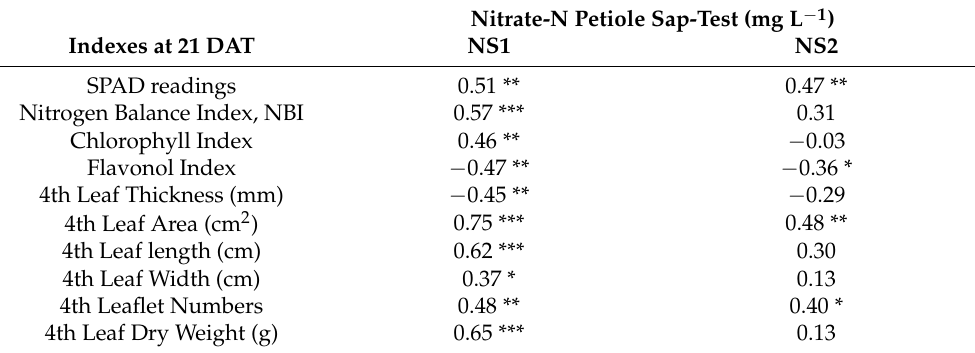
Table 3. Pearson’s correlation coefficients between Nitrate-N Petiole Sap-Test and indexes measured on the 4th leaf of potato plants grown in aeroponics with Otaz ú ’s nutrient solution (NS1) and modified Furlani’s nutrient solution (NS2).